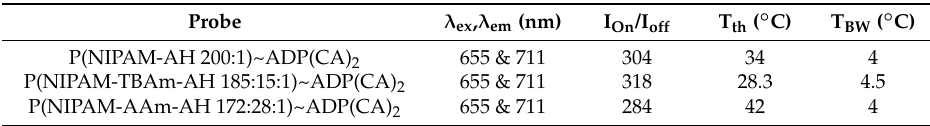
Figure 7. Fluorescence intensity changes of ADP(CA) 2 -conjugated thermosensitive polymers as a function of temperature; The three temperature probes are P(NIPAM-AH 200:1)~ADP(CA) 2 , P(NIPAM-TBAm-AH 185:15:1)~ADP(CA) 2 and P(NIPAM-AAm-AH 172:28:1); Excitation wavelength: 655 nm; Emission filter: 711/25 band-pass filter and a neutral density filter with OD 0.9. Laser energy: 700pJ. OD: optical density. Table 2. Overview of temperature probes.